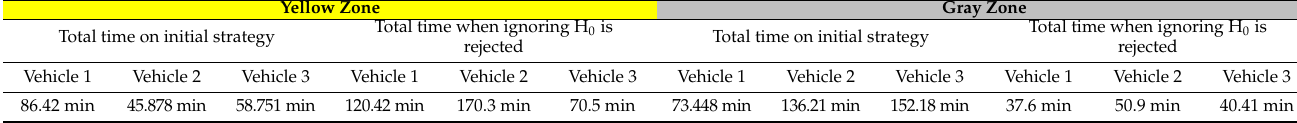
Table 4. The risks when ignoring H 0 is rejected (for the yellow zone and gray zone). Yellow Zone Gray Zone